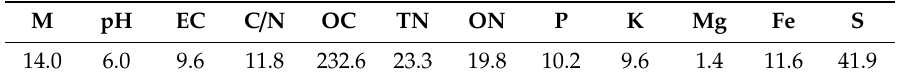
Table 3. Chemical analysis of the commercial organic amendment (COA), nutrients, given on a dry matter